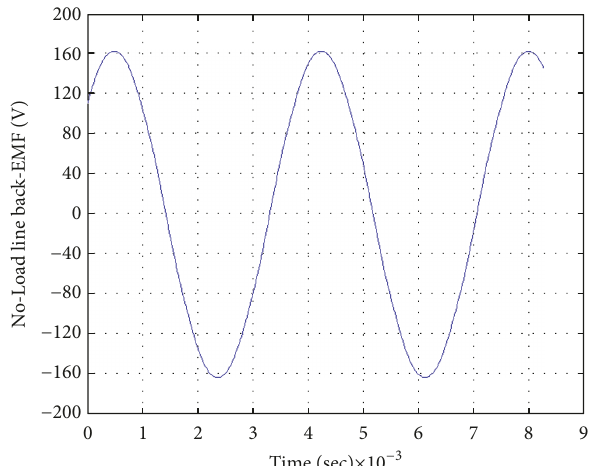
Figure 4: No-Load line back-EMF simulation waveform at 4000r/min.